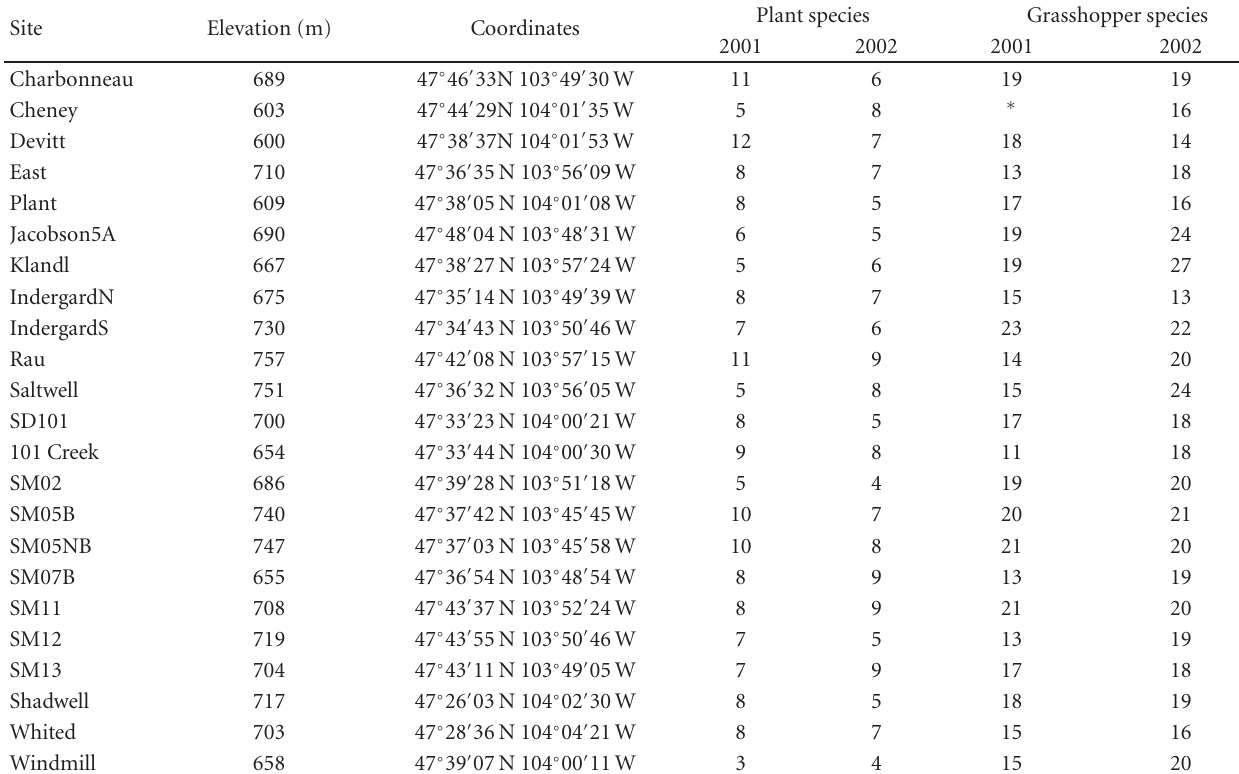
Table 1: Characteristics of each site in western North